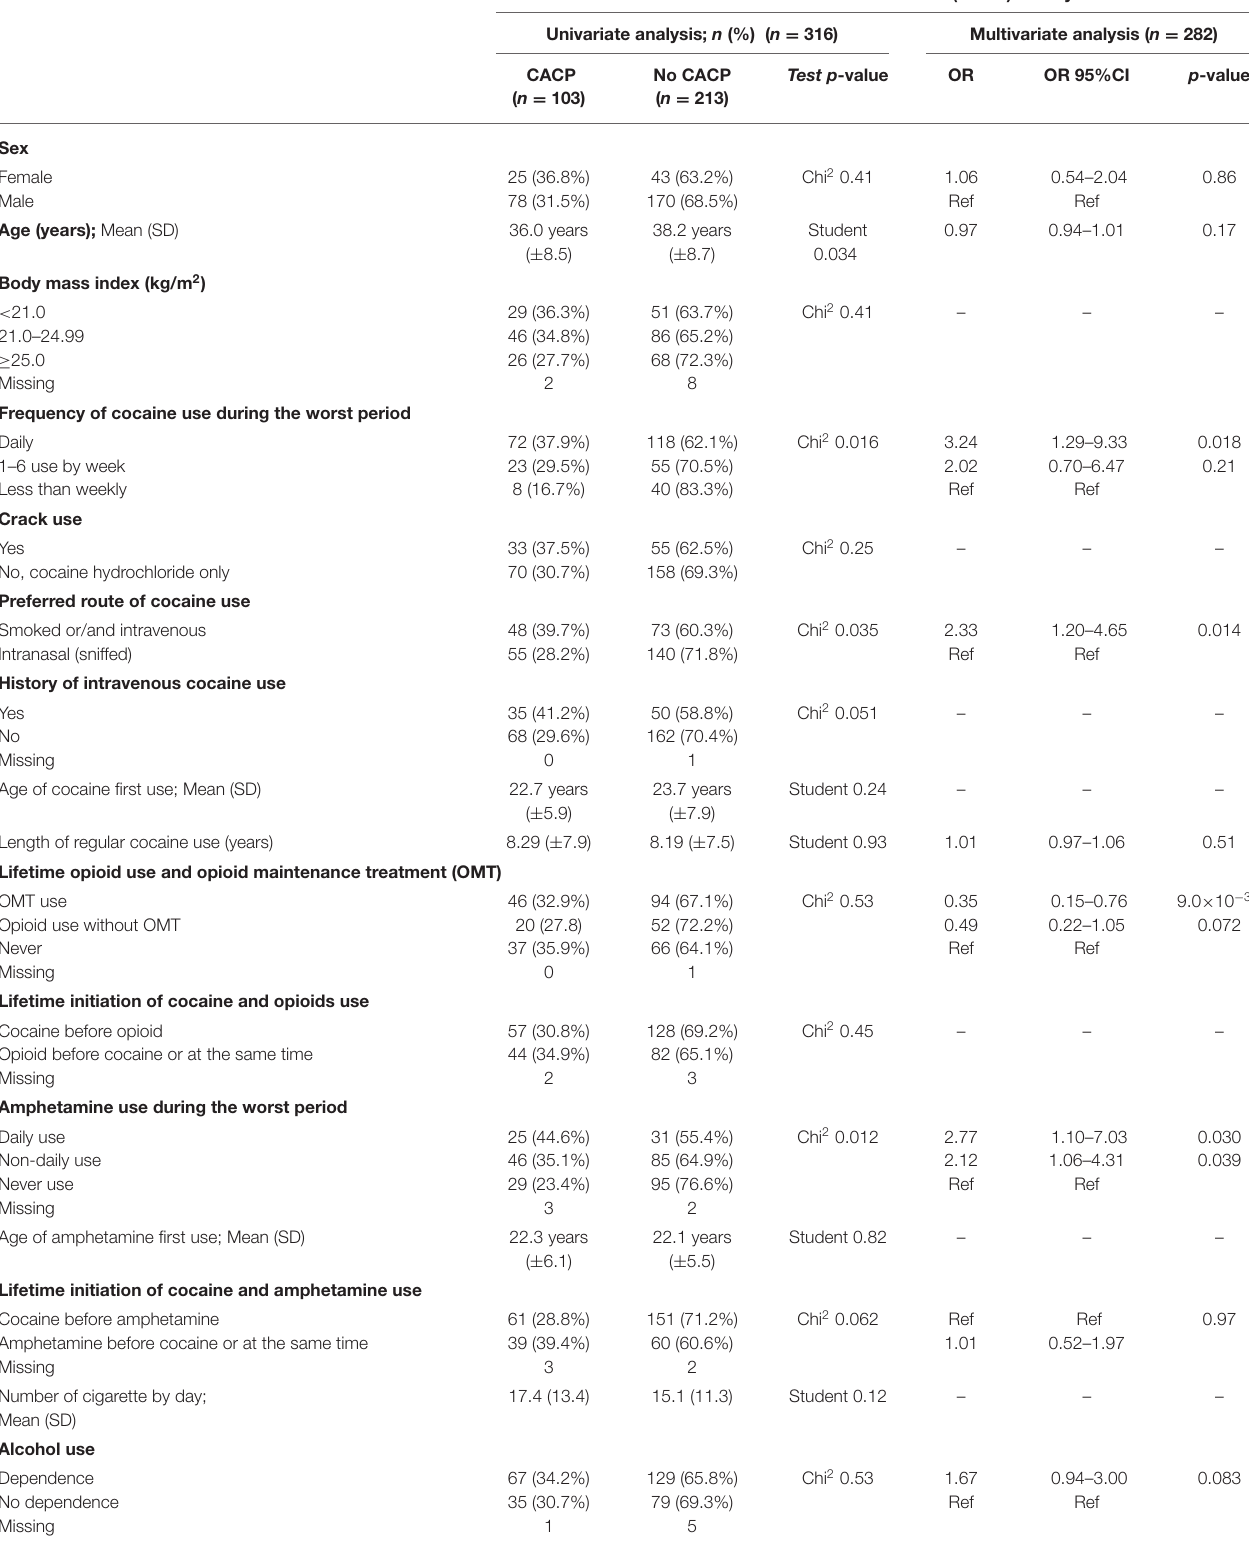
TABLE 3 | Analyses of lifetime CACP history ( n =